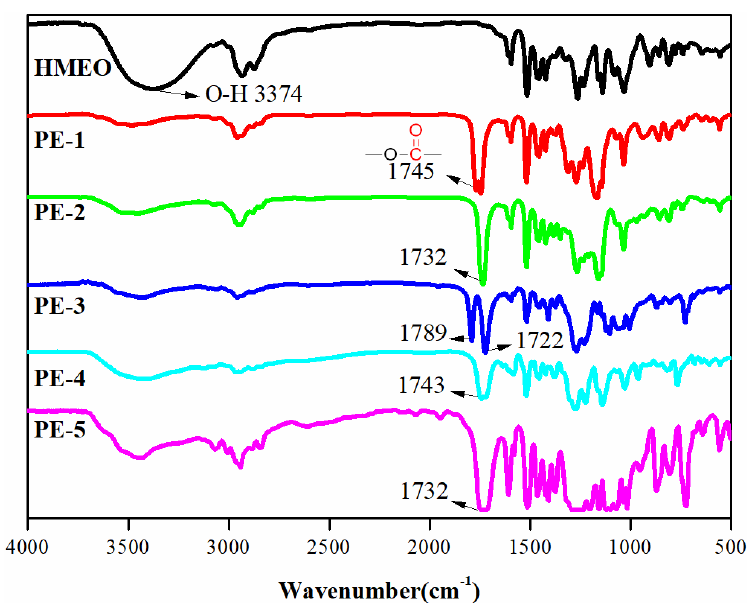
Figure 3. FTIR spectra of PEs and HMEO.